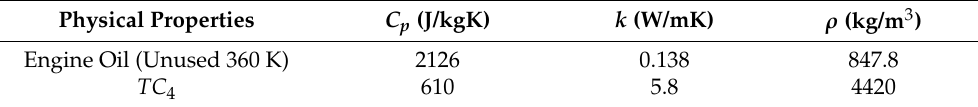
Table 1. The thermophysical properties of base fluid and